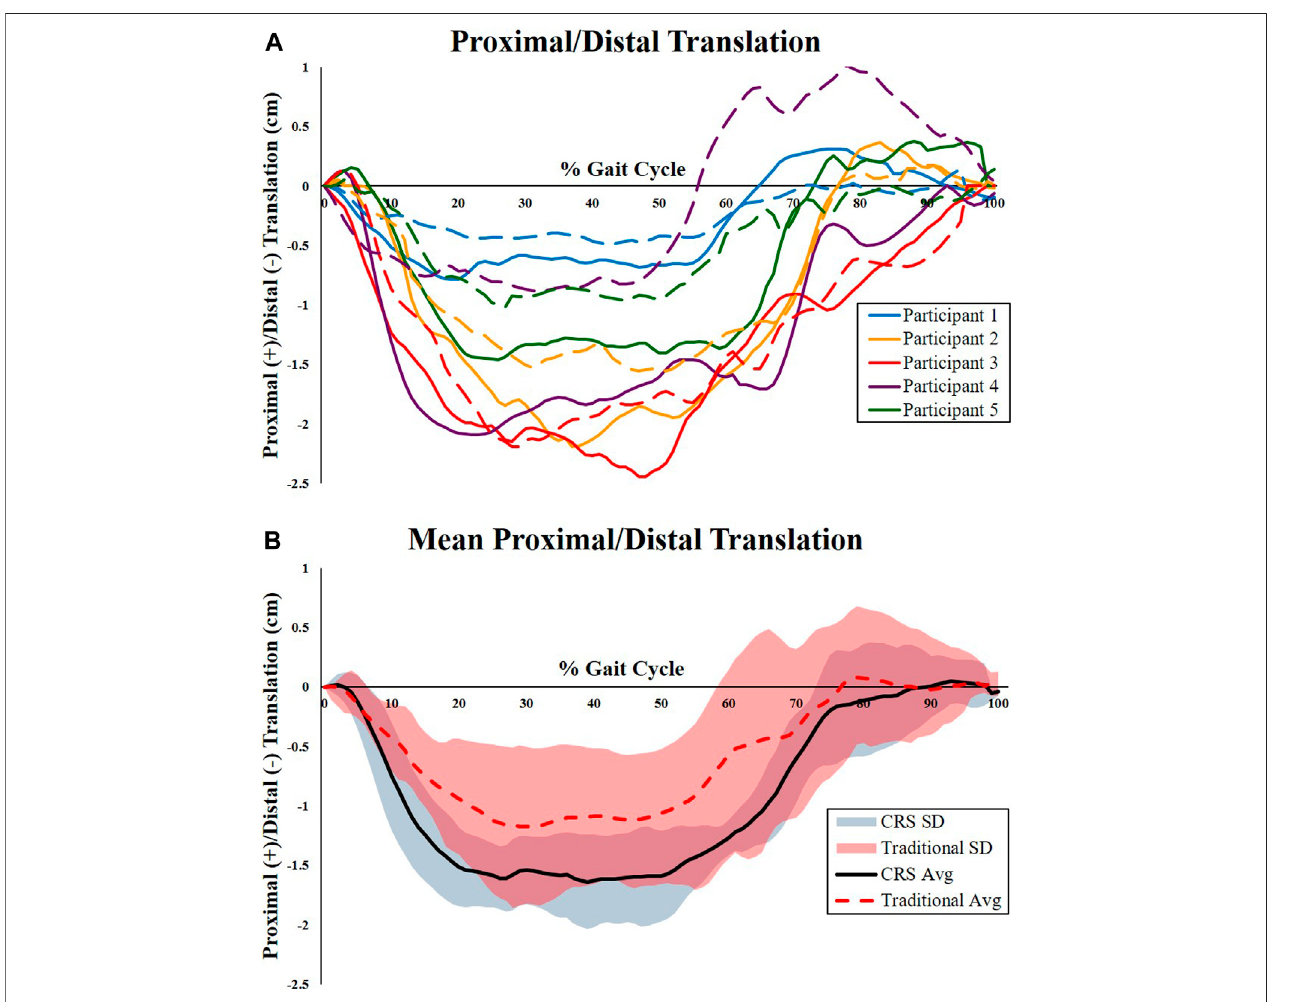
FIGURE 2 | Proximal-distal kinematics of the residual femur relative to the prosthetic sockets. (A) Individual kinematic proximal-distal plots of the femur for each participant relative to the corresponding socket type. Dashed lines represent relative femur movement in the traditional IC socket. Solid lines represent relative femur movementintheCRSsocket.Participant 5(Green line)used pinlockingsuspension.Allotherparticipants usedsuctionsuspension. (B) Meanand standarddeviationof the proximal-distal kinematics of the residual femur relative to the traditional IC socket (dashed line) and CRS socket (solid line). The traditional socket had signi fi cantly less proximal-distal translation compared to the CRS